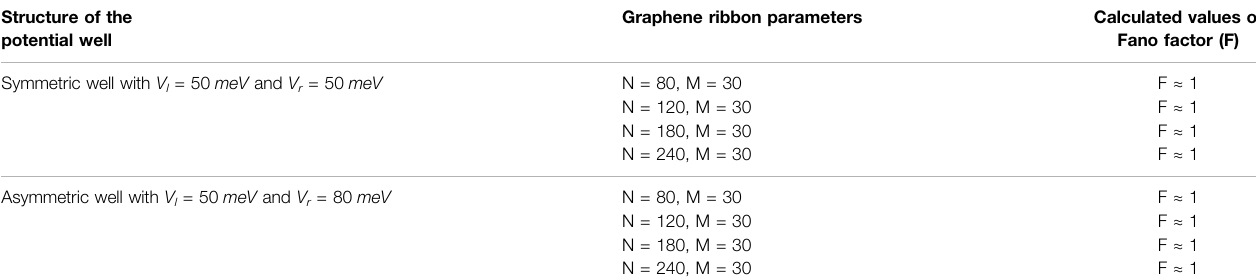
TABLE 1 | Calculated values of Fano factor for different cases. Structure of the potential well